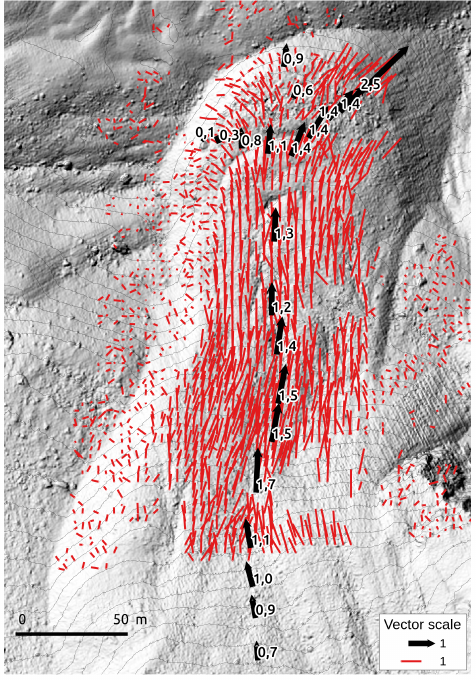
Figure 2. Surface velocity (m/yr) on the Laurichard rock glacier for the period 2011–2012 quantified by image correlation on DEMs (red lines) and by ground topographic (total station and DGPS) measurements of marked blocks (black